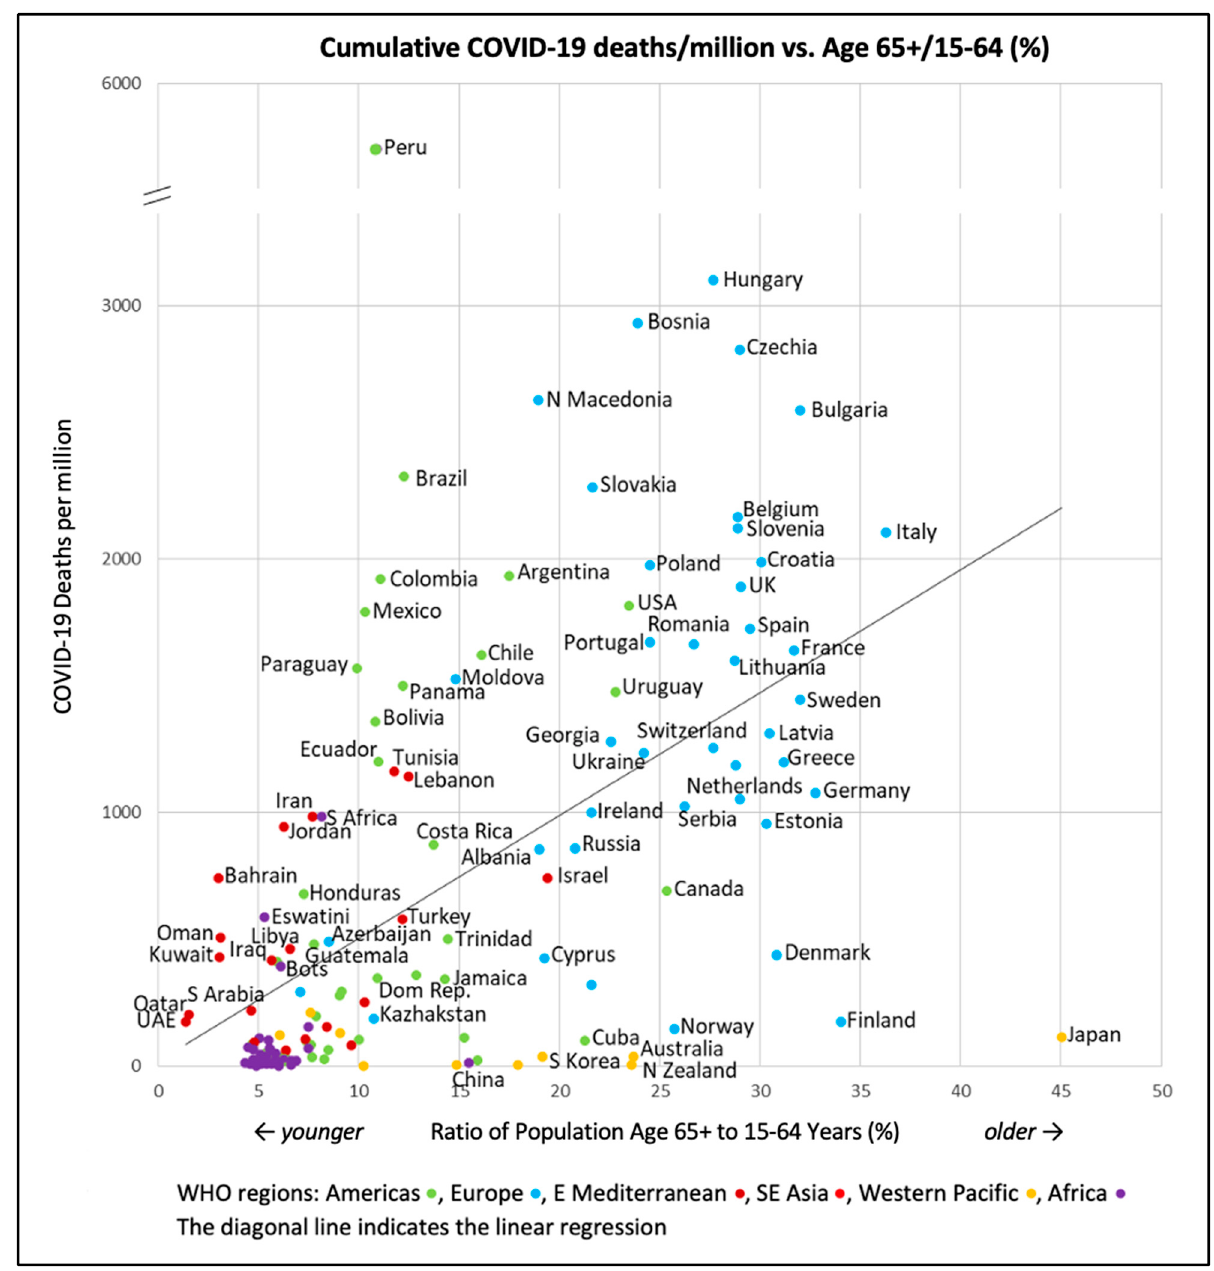
Figure 1. This analysis is based on data extracted from ourworldindata.org on June 17, 2021, retaining data on countries with populations of at least 1 million, for which complete data were available for the analyses done. Among these countries, as one would expect, COVID-19 mortality is strongly correlated with age structure. Note the concentration of purple dots in the bottom left, indicating comparatively low COVID-19 mortality and young age structure among most African countries. The Pearson’s R 2 for cumulative COVID-19 mortality and the ratio of persons aged 65+ to those aged 15–64 is 0.283; for example, 28.3% of the between-country variance in cumulative COVID-19 mortality can be accounted for by age structure alone.